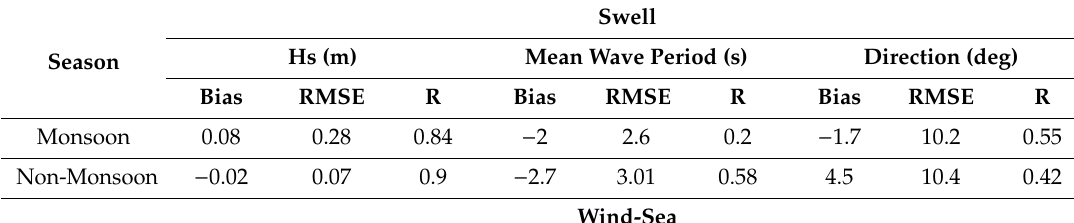
Table 4. Statistical comparison of swell and wind-sea parameters between measured and model data during monsoon and non-monsoon.